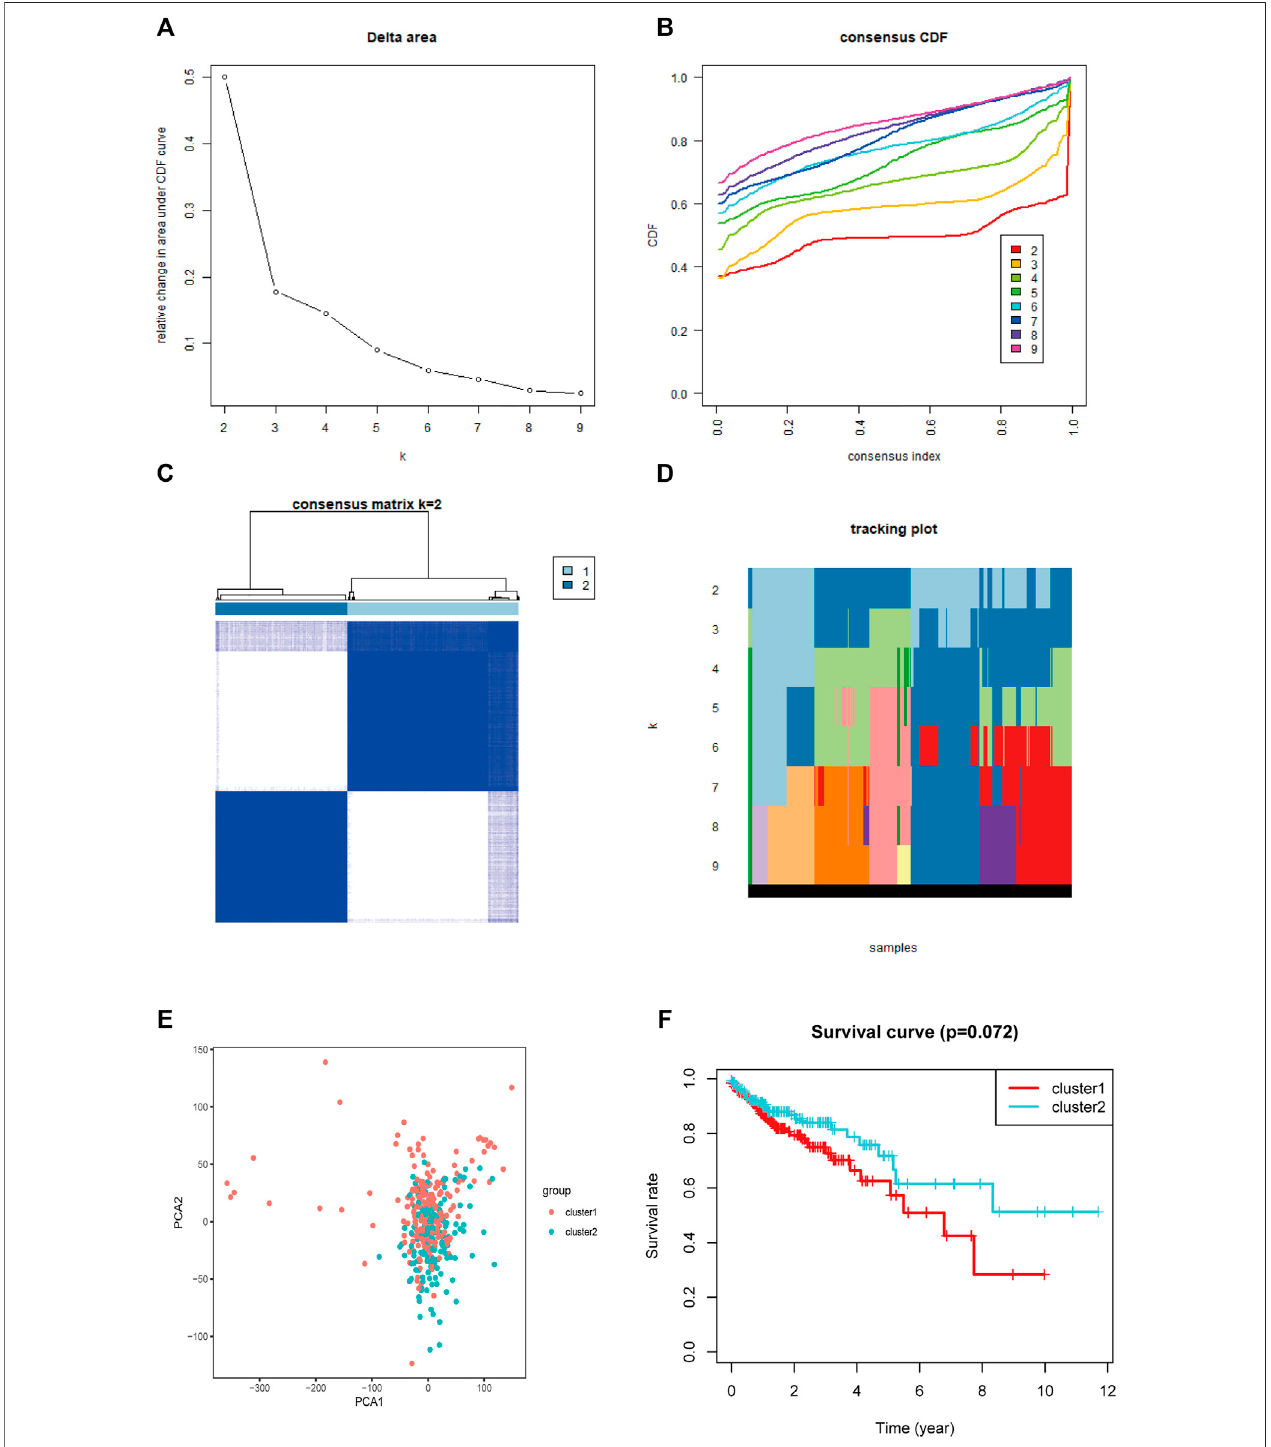
FIGURE6| Consistentcluster analysisand principalcomponentanalysisofCOAD. (A) Theconsistencyclusteringcumulativedistributionfunction(CDF)when k is between 2 and 10. (B) The relative change of the area under the CDF curve from 2 to 10 of k. (C) At k = 2, the correlation between groups. (D) The distribution of the samplewhen k isbetween2and 10. (E) Principal component analysis of2clustersoftotalRNAexpression pro fi leafter consistencyanalysis. (F) Comparison ofKaplan- Meier overall survival curves for COAD patients in cluster Ⅰ and Ⅱ .